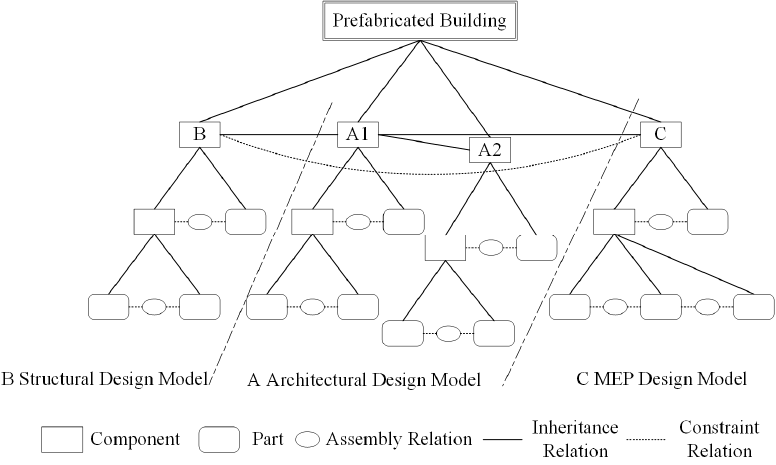
Figure 6. Assembly model specialized distribution structure.